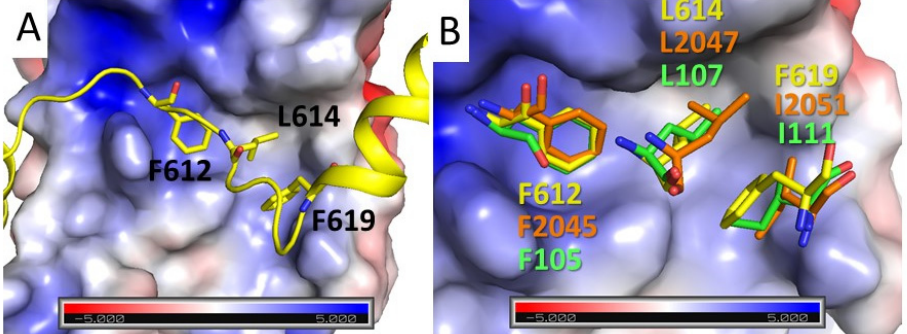
Figure 3. Hydrophobic interactions of the core signature motif. ( A ) Cartoon representation of PALB2 peptide in yellow with the conserved hydrophobic amino acids of the FxLP motif interaction with MRG shown in the surface representation and color-coded according to surface electrostatic potential. ( B ) Conformation comparisons of three hydrophobic amino acids of the FxLPxx Φ motif from three different MRG-interacting peptides with carbon atoms of PALB2 shown in yellow, of 2N1D shown in green, and of 2INE in orange. All complexes were superimposed by MRG subunits shown as in panel A.